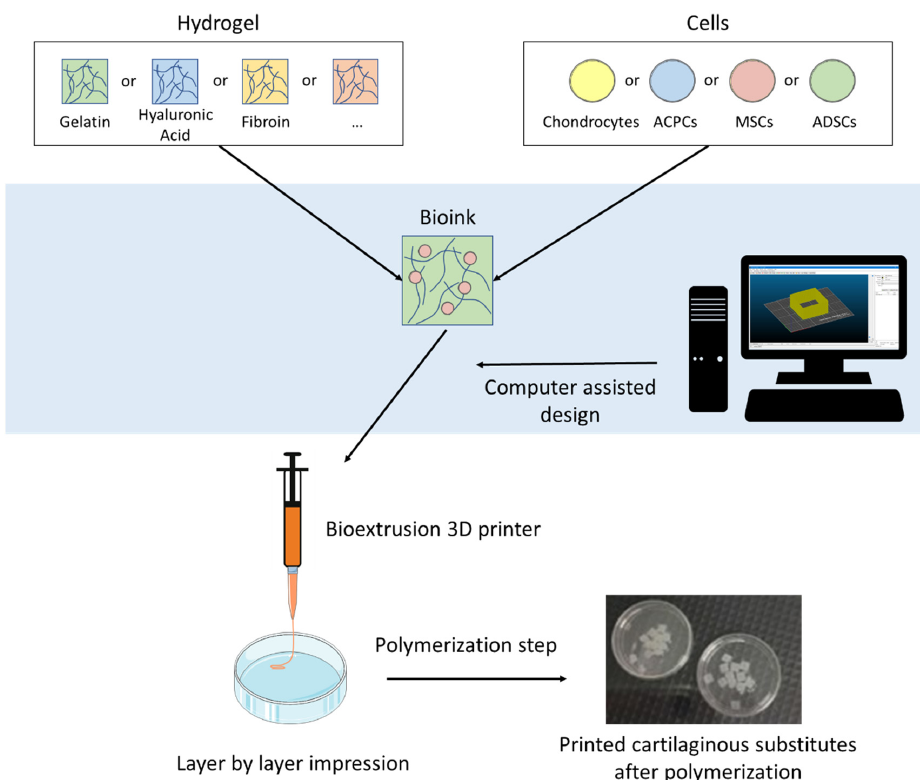
Figure 1. Schematic illustration of the extrusion-based 3D bioprinting process for articular tissue engineering using various hydrogels and cell types.